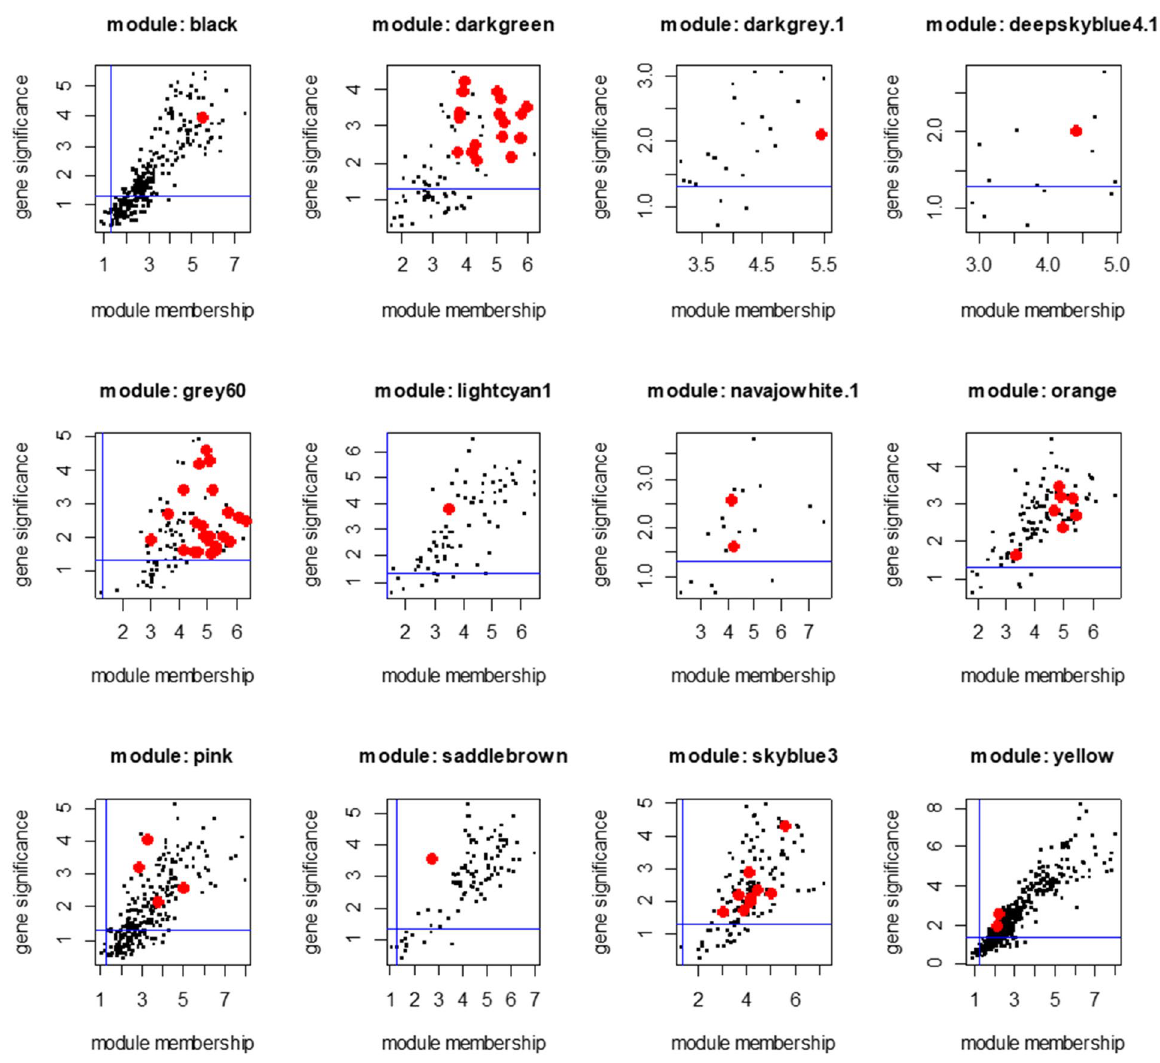
Figure 2. Hub miRNAs (red dots) identified in each co-expression module in C3H mice. The circulating miRNAs identified displayed strong memberships, based on WGCNA criteria, within each module and significant correlations with the HCC phenotype. Blue lines: p <